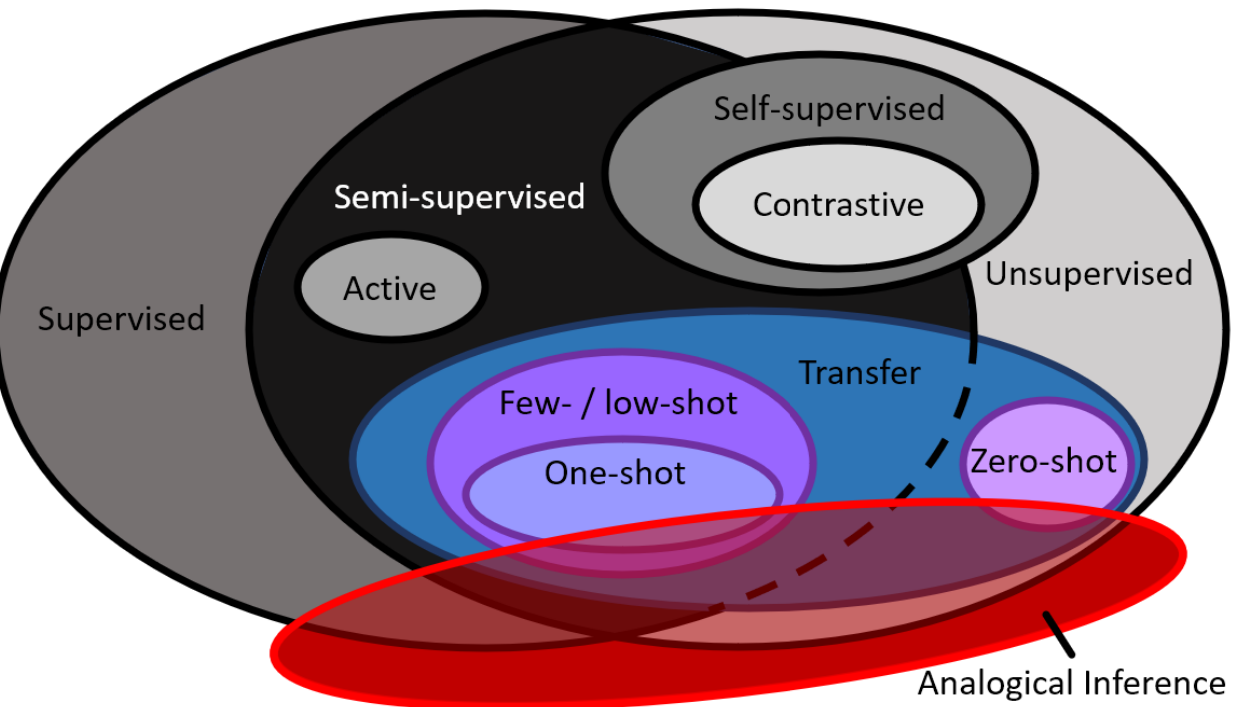
Figure 1. Venn diagram of popular machine learning algorithms: Hierarchy and relationship(s) between common types of machine learning are presented along with the two types on which this article focuses, transfer learning and analogical inference, which are denoted within the blue and red regions, respectively. Purple regions represent types of learning that often fall under either category. Set and set-overlap sizes are not necessarily depicted to scale; emphasis is on the general overlap between sets.